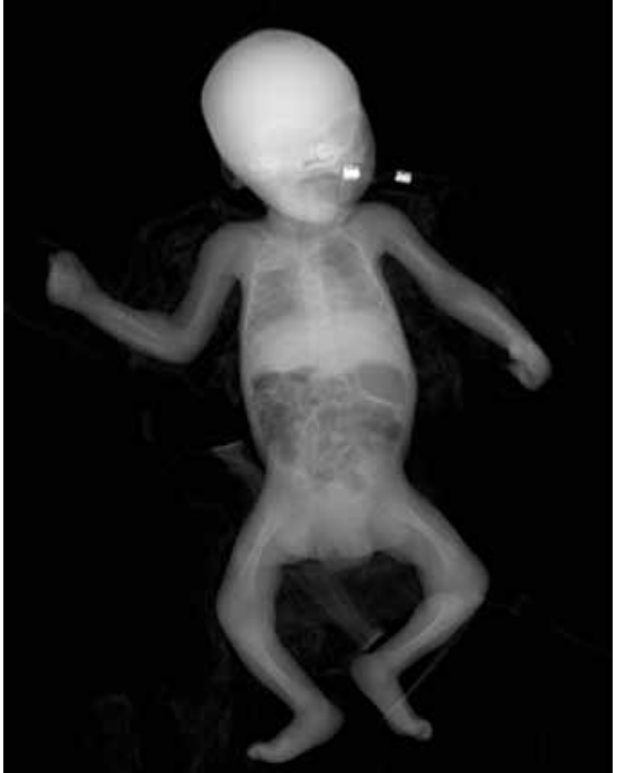
Fig. 3. Full body image with opacification in the right upper lobe of the lung.